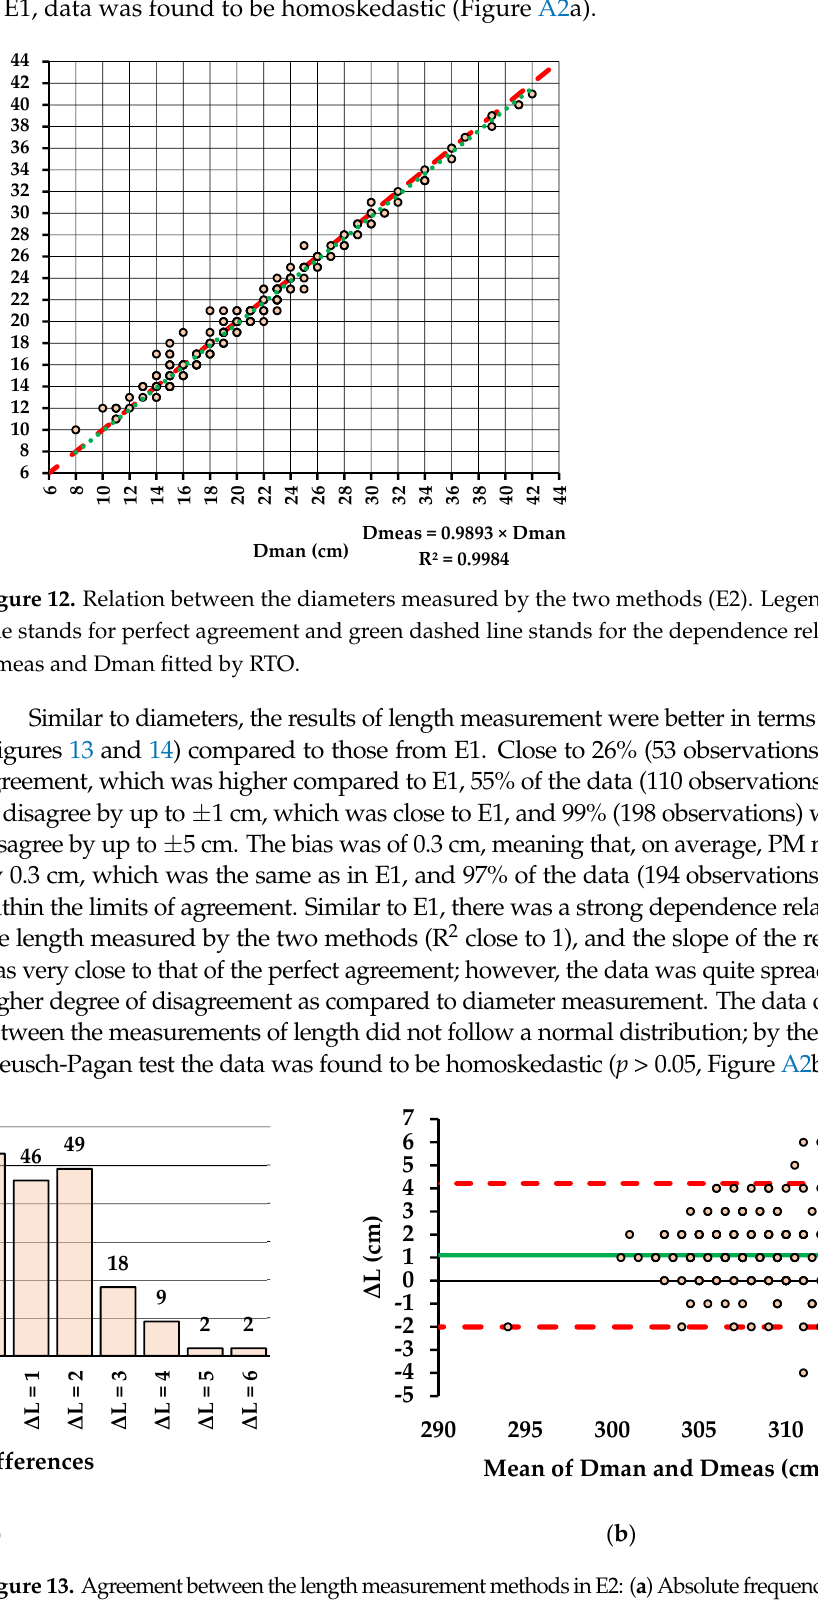
agreement (red dashed lines).